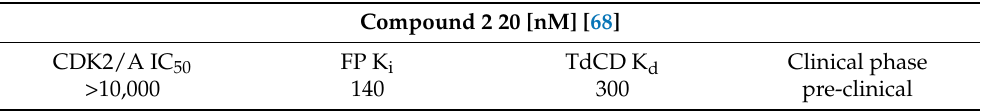
Table 3. Selected biological data obtained from different assays with quinoline-based compound demonstrating that it targets monomeric CDK2.